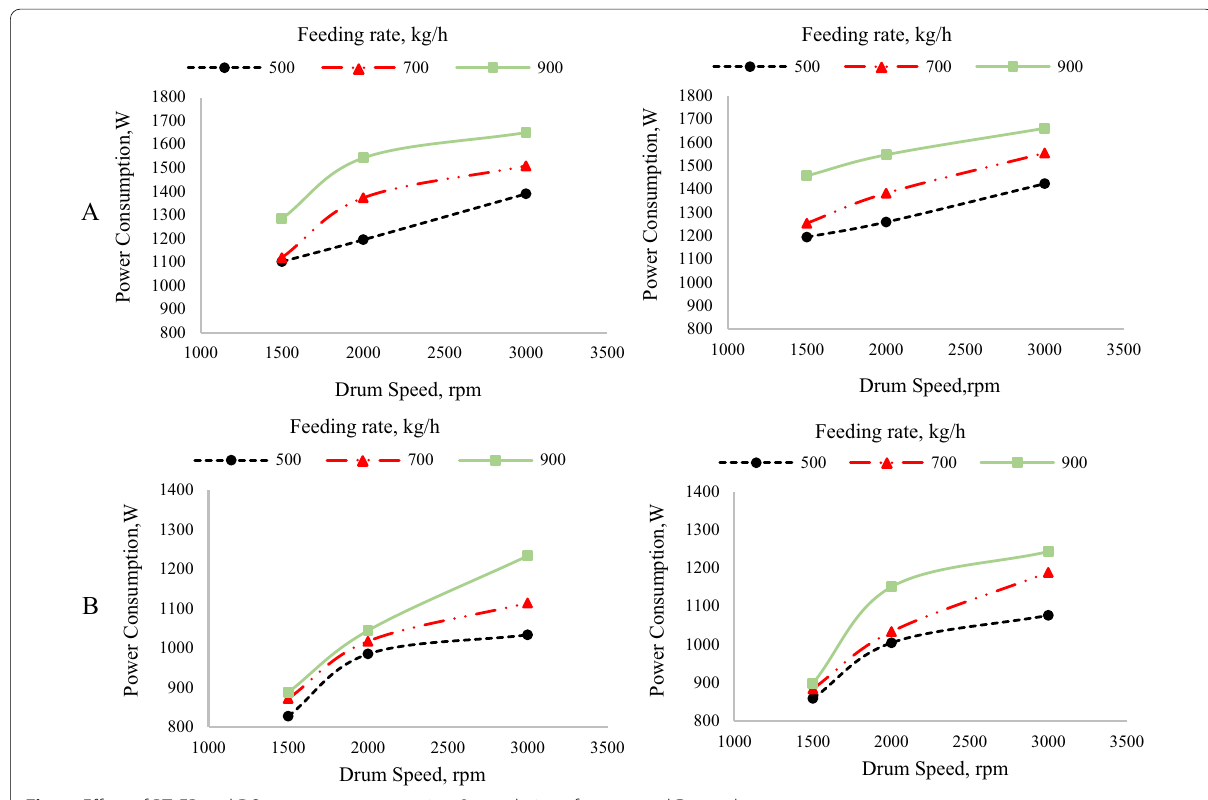
Fig. 5 Effect of RT, FR and DS on power consumption A sun drying after one and B two